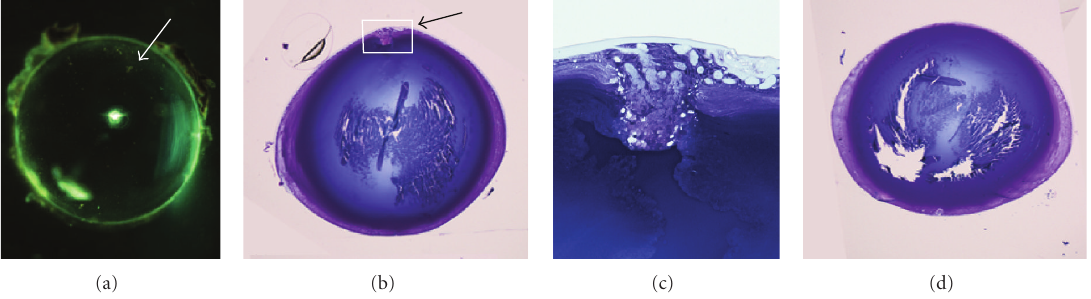
Figure 4: Lens defect in AKR1B10 lens after long-term diabetes. (a) Brightfield microscopy of transgenic lens demonstrating light scattering defect (arrow). (b) AKR1B10 transgenic lens showing defect at the anterior aspect of the lens (arrow). (c) Magnification of the boxed area from panel (b). (d) Lens from nontransgenic control with equivalent duration of diabetes. Panels (b)–(d) are from toluidine blue-stained